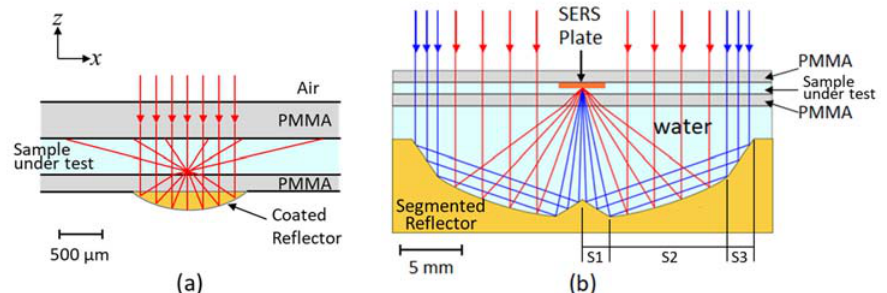
Figure 1. Side-view illustration of ( a ) our previously reported freeform reflector embedded lab-on-chip (NA = 1.24) [14] and ( b ) the segmented reflector-based Raman system with SERS microfluidic chip (NA = 1.15). The red and blue rays refer to the incident light that interact with di ff erent segments of the reflector. (S1: center segment; S2: middle concave segment; S3: marginal